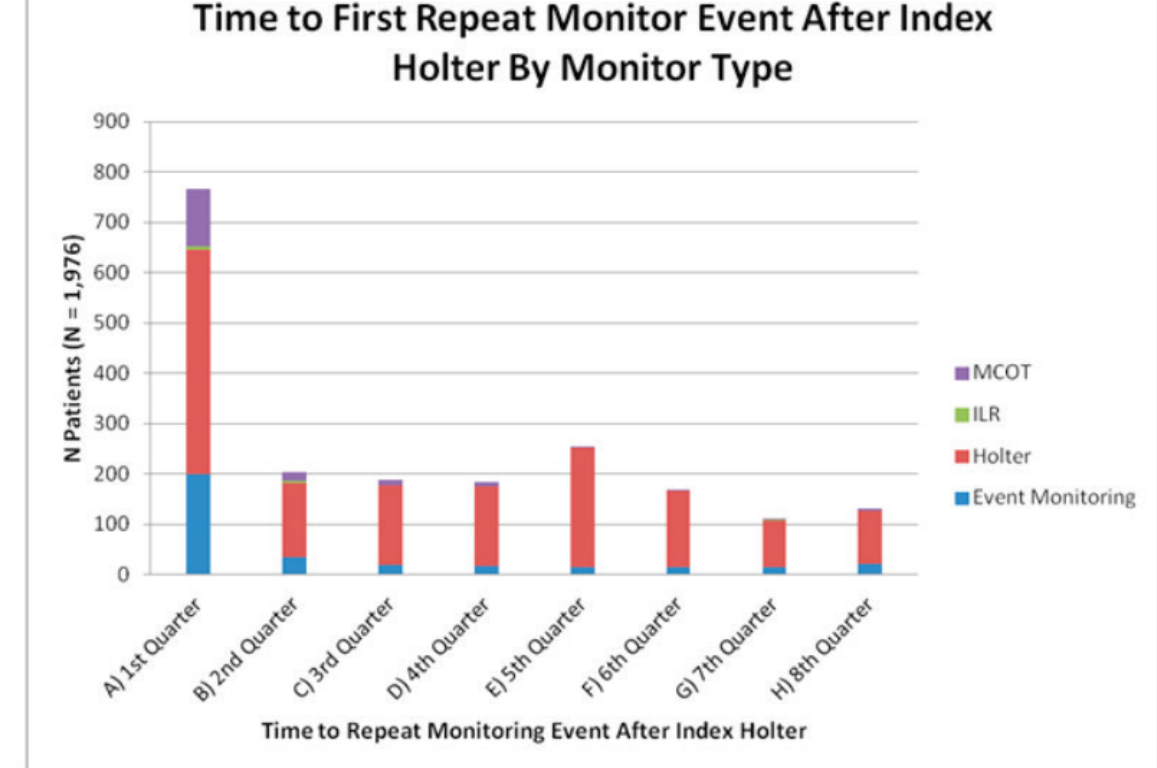
Allowed Charges Average Total Per Patient Inpatient Outpatient Total Part B